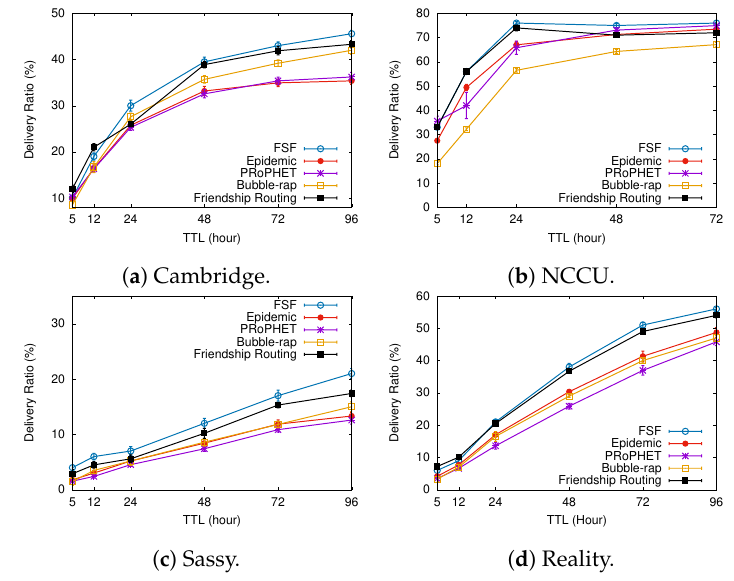
Figure 5. Delivery ratio when increasing message